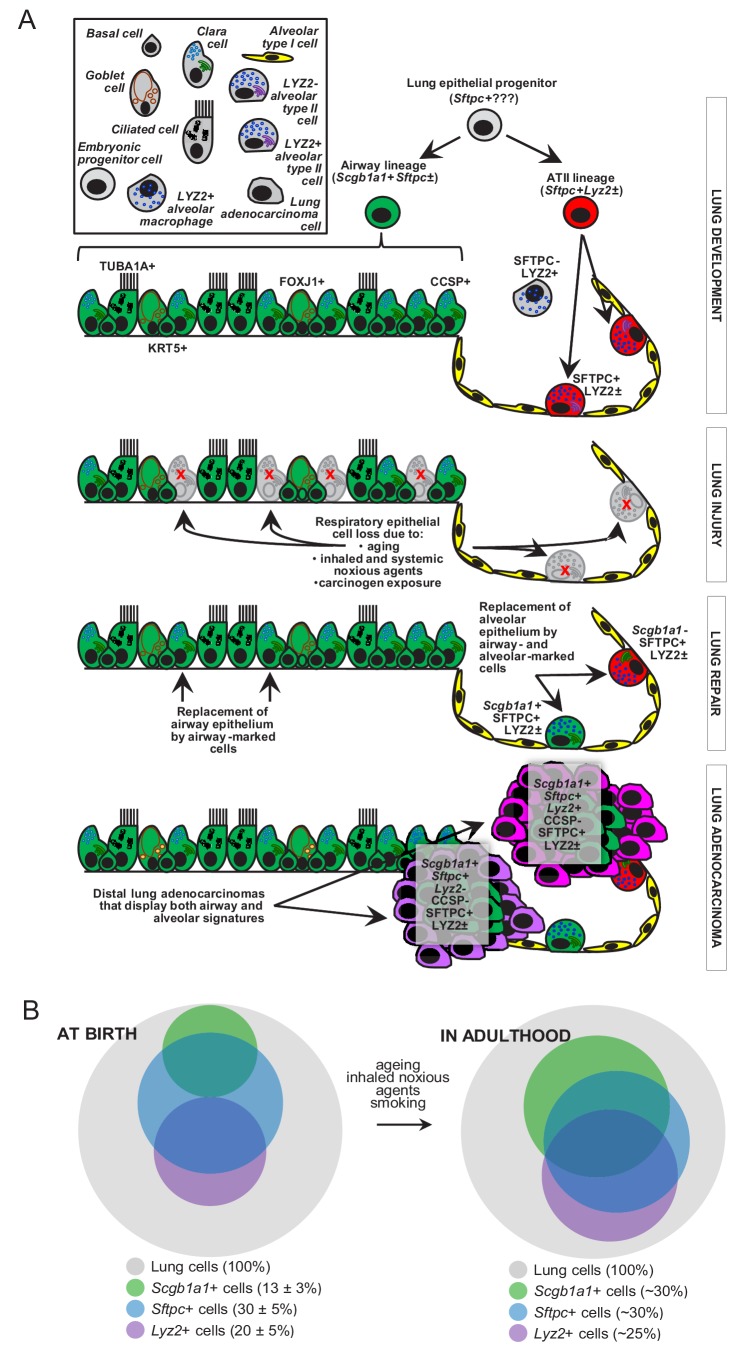
Proposed role of airway-marked cells in murine lung maintenance and adenocarcinoma.(A) Our evidence supports the existence of distinct developmental ancestries for airway epithelial (AEC) and alveolar type II (ATII) cells, notwithstanding their common descent from an early (possibly Sftpc+) lung epithelial progenitor. The developmental airway lineage (Scgb1a1+ Sftpc±; green) gives rise to all types of airway cells, including club, ciliated, goblet, basal, and other cells, while the developmental ATII lineage (Sftpc+ Lyz2±; red) gives rise to ATII cells before birth. These lineages appear to be segregated in the growing unaffected lung of the mouse till the age of six weeks, which roughly corresponds to a human age of six years, where cellular proliferation in the human lungs ceases. Thereafter, and likely due to the continuous exposure of the lungs to inhaled noxious agents, gradual expansion of Scgb1a1+ Sftpc± marked cells ensues. Upon lung injury, this process is accelerated. Similarly, during carcinogenesis caused by chemical tobacco smoke carcinogens, Scgb1a1+ Sftpc± marked cells expand and are ubiquitously present in peripheral lung adenocarcinomas. (B) Proposed neonatal proportions and postnatal dynamics of pulmonary epithelial cells during adulthood. Estimated proportions of lineage-marked cells at birth, based on flow cytometry and co-localization of proteinaceous and genetic cell marking. Lung lineages appear to be segregated in the growing lung till the age of full lung development (six weeks in mice and 6–8 years in humans) or till lung injury ensues. Schematic of proposed postnatal redistribution of marked cells in the adult lung. Upon injury, during multi-stage field carcinogenesis, or even during unchallenged aging, Scgb1a1+ marked cells appear in the distal alveolar regions, thereby maintaining lung structure and function. Bubble size indicates relative marked cell abundance. CCSP, Clara cell secretory protein; FOXJ1, forkhead box J1; KRT5, keratin 5; LYZ2, lysozyme 2; SFTPC, surfactant protein C; TUB1A1, acetylated α-tubulin.